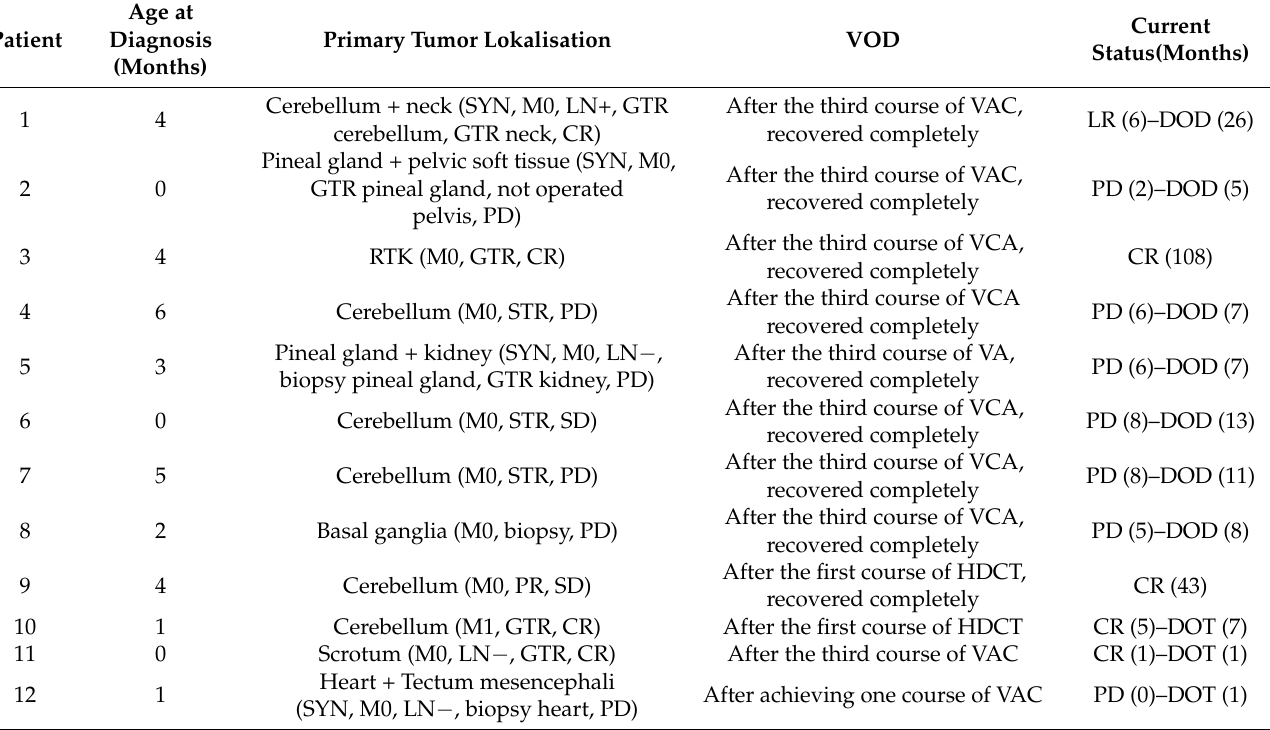
Table 4. Veno-occlusive disease